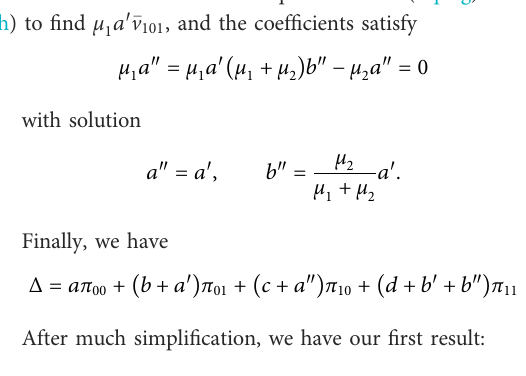
FIGURE 4 Average age vs. λ , μ = 1, queue capacity of one, without preemption. Simulation results are indicated by the points, theoretical results are indicated by the solid line, and simulation minima are indicated by △